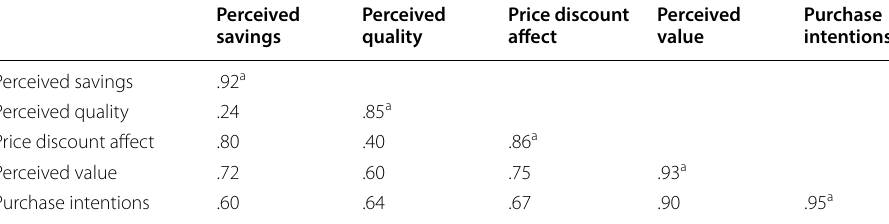
a Square root of the AVE value for each construct